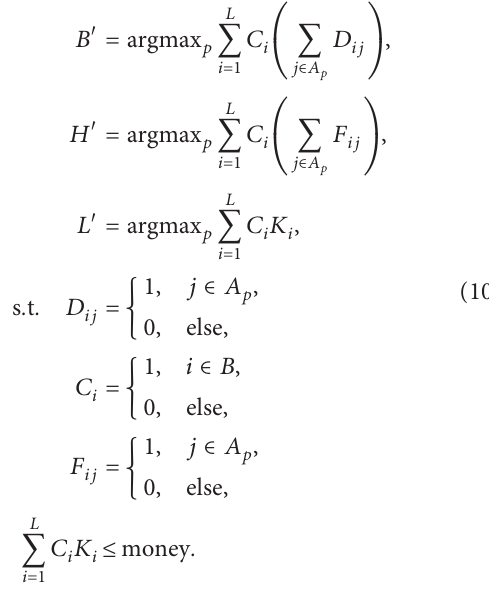
algorithm based on NSGZ-II to search for the Pareto optimal solution of the